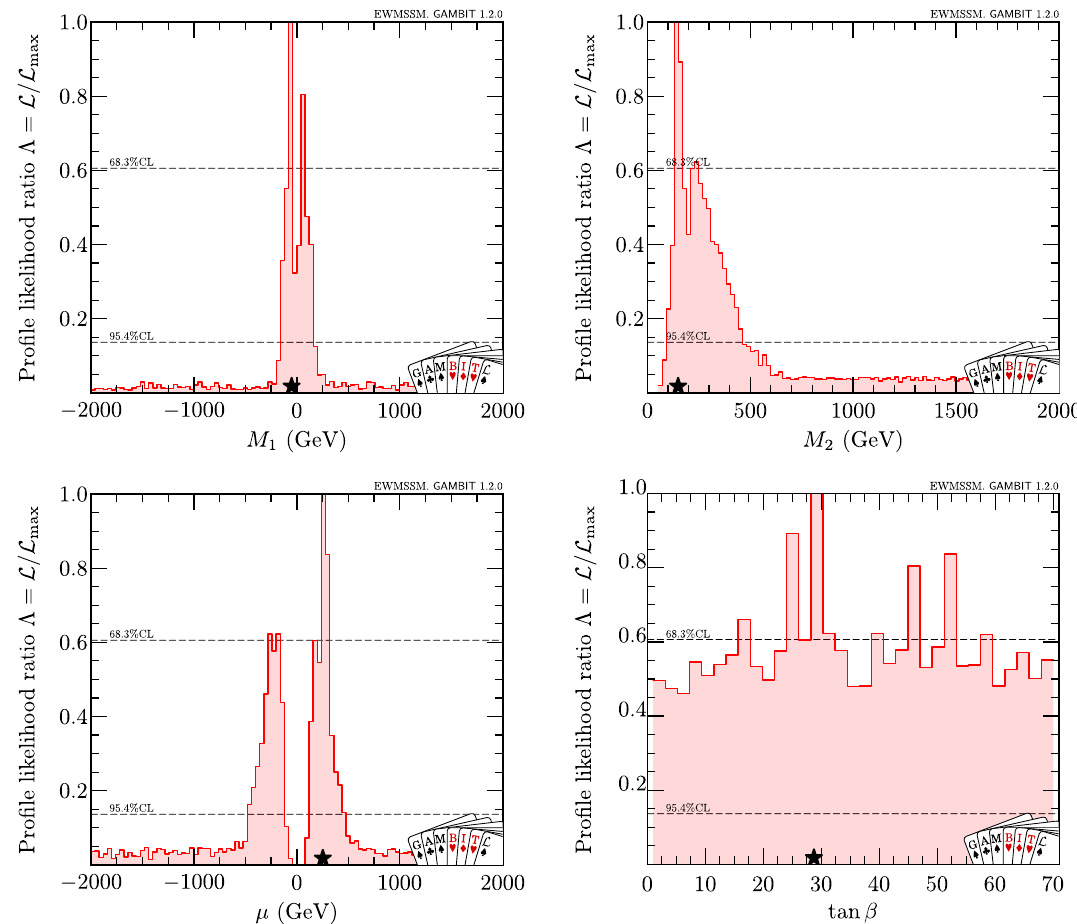
Fig. 15 One-dimensional profile likelihood for the electroweakino sector parameters: M 1 (top left), M 2 (top right), μ (bottom left) and tan β (bottom right). The dashed black lines show the 1 σ and 2 σ confidence limit and the black star marks the best-fit point